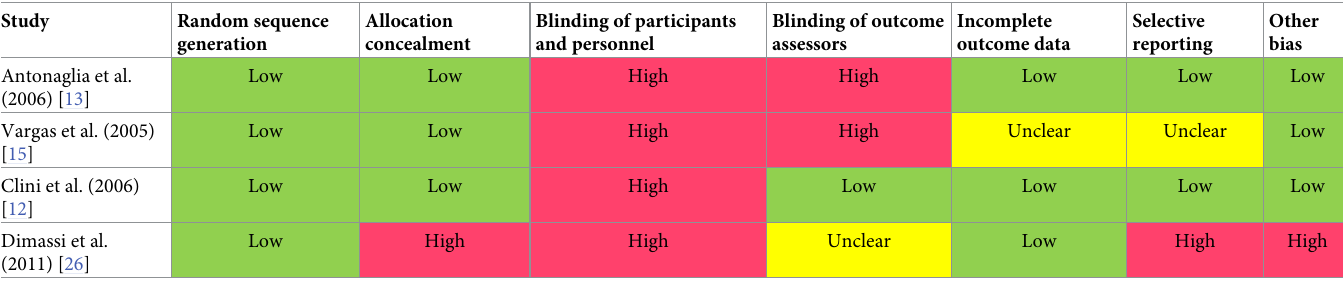
Table 1. Cochrane assessment of the risk of bias. Study Random sequence